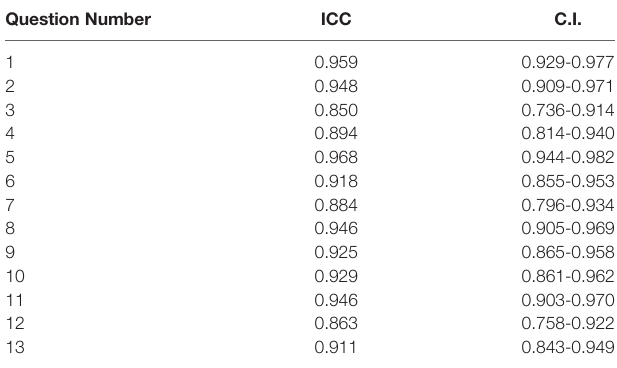
TABLE 4 | ICC and 95% con fi dent intervals for every question of